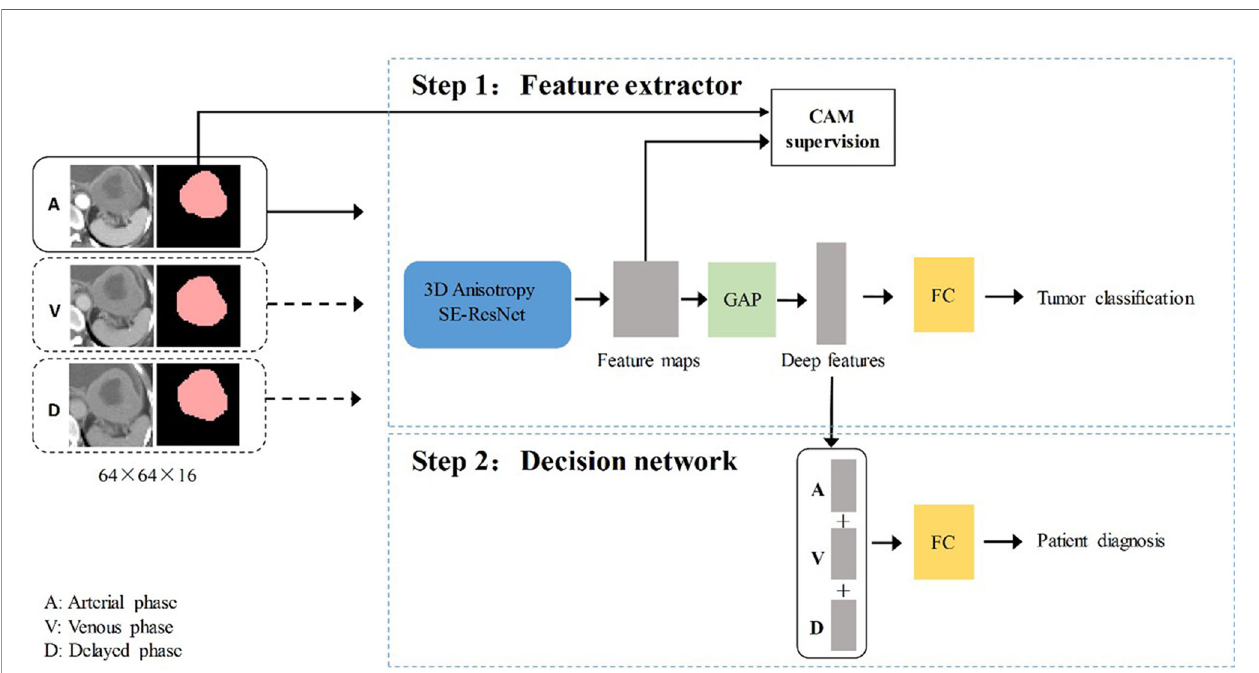
FIGURE 2 | The overall gastrointestinal stromal tumors risk strati fi cation framework. CAM, class activation mapping; A, arterial phase; V, venous phase; D, delayed phase; FC, fully connected layer; GAP, global average pooling